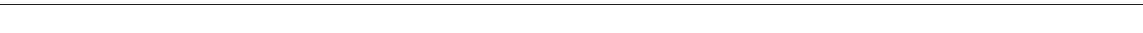
Fig. 2 USP52 is a deubiquitinase. a In vitro deubiquitination assays with E . coli cells-puri fi ed UCH domain of USP52 (USP52/UCH, 1 μ g) and K48-linked tetra-ubiquitin linkages (1 μ g) under different time points as indicated. The cleavage effect was examined by western blotting with antibody against ubiquitin. The asterisk indicates the recombinant protein stained by Commassie Blue. b In vitro deubiquitination assays with Sf9 cells-puri fi ed USP52/UCH (1 μ g) and K48-linked tetra-ubiquitin linkages (1 μ g) under different time points as indicated. The cleavage effect was examined by western blotting with antibody against ubiquitin. The asterisk indicates the recombinant protein stained by Commassie Blue. c In vitro deubiquitination assays with different types of ubiquitin linkages and increasing amounts of Sf9 cells-puri fi ed USP52/UCH (1 and 3 μ g) or control eluents. After 4 h of incubation, the cleavage effect was examined by western blotting with antibody against ubiquitin. d In vitro deubiquitination assays with different types of ubiquitin linkages (1 μ g) and HeLa cells-puri fi ed full-length USP52 (1 μ g) or UCH domain de fi cient USP52 (USP52/ Δ UCH, 1 μ g) with high salt and detergent buffer. After 4 h of incubation, the cleavage effect was examined by western blotting with antibody against ubiquitin. The asterisk indicates the recombinant protein stained by silver staining. e In vitro deubiquitination assays with K48- or K63-linked tetra-ubiquitins (0.5 μ g) and Sf9 cells-puri fi ed USP52/UCH (3 μ g) in the presence or absence of 2 mM alkylating reagent N -ethylmaleimide (NEM). Sf9 cells-puri fi ed recombinant C-terminal USP7 (UCH domain and C-terminal ubiquitin- like domain, 1.5 μ g) was taken as a positive control. After 4 h of incubation, the cleavage effect was examined by western blotting with antibody against ubiquitin. f In vitro deubiquitination assays with K48- or K63-linked tetra-ubiquitins (0.5 μ g) and Sf9 cells-puri fi ed USP52/UCH (3 μ g) or cysteine mutant of UCH domain (C528A/C530A, 3 μ g). After 4 h of incubation, the cleavage effect was examined by western blotting with antibody against ubiquitin. CA represents mutant carrying both C528A and C530A